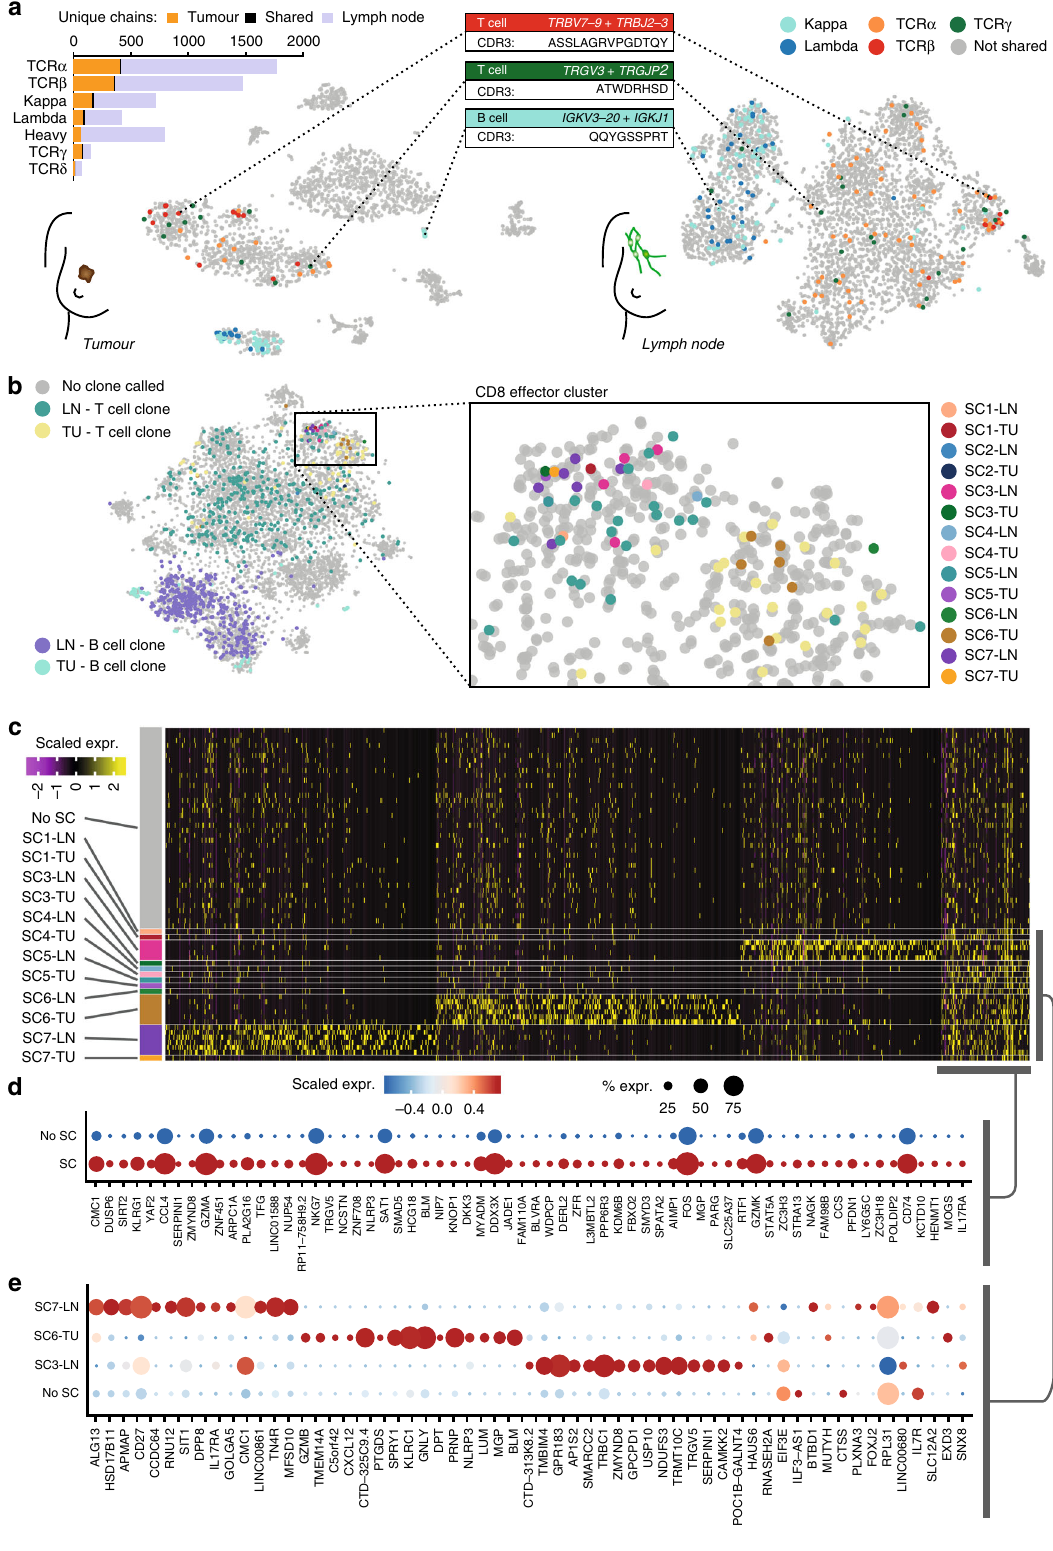
To investigate whether clonally related lymphocytes across the tumor and lymph node have common gene-expression features, we analyzed T-cell clones expressing identical TCR β chains found across both tissues (Supplementary Data 1). Integration of tumor and lymph node gene-expression datasets revealed that cells